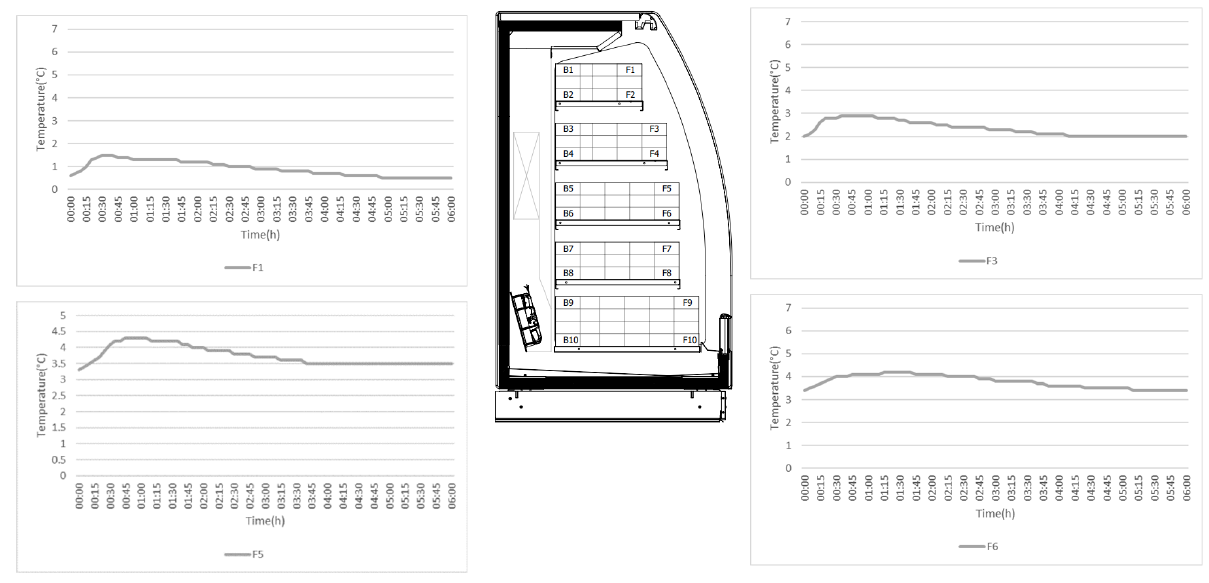
Figure 13. Distribution of the temperature of food products in the middle plane of the refrigerated cabinet (experimental data). Table 4. Comparison of the temperatures of food products obtained in numerical and experimen- tal